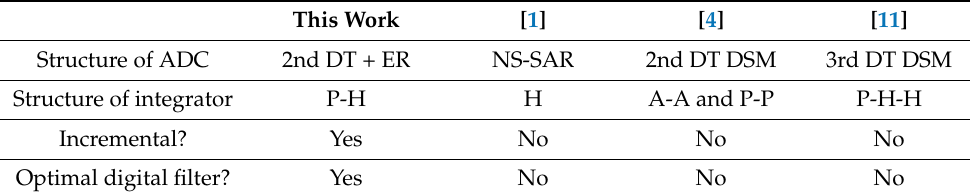
Table 1. Comparison with other analog-to-digital converters (ADCs) using passive integrators. This Work [1] [4] [11] Structure of